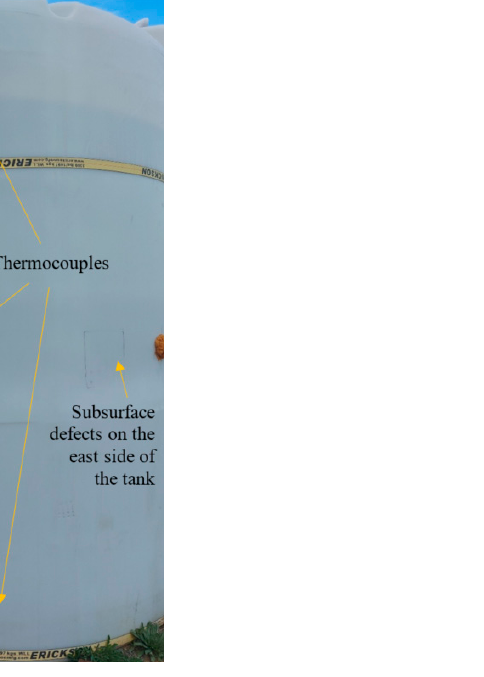
Figure 1. The configuration of the tank under study and the arrangement of the installed thermocouples. According to the method and duration of the heating and thermographic data analy- sis procedures, the active thermography techniques fall into the following subcategories: pulsed thermography, step-heating thermography, modulated lock-in thermography, vi- brothermography, pulse-compression thermography, and thermal wave imaging